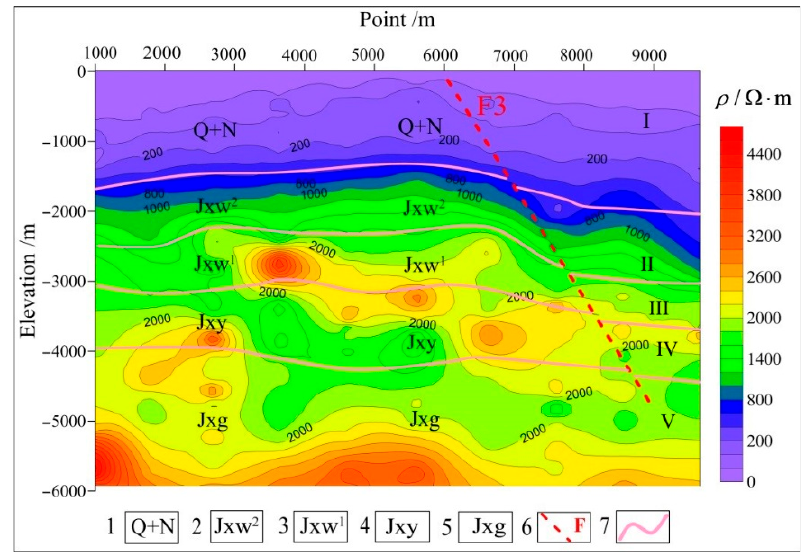
Figure 5. Integrated MT interpretation of a section of survey line L3(refer to Figure 3 for an explanation of the symbols).